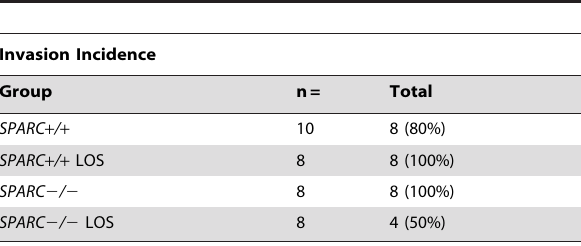
Table 2. Losartan reduces tumor invasion in SPARC 2 / 2 animals.